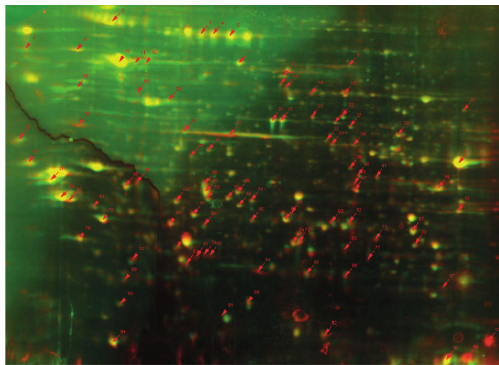
Figure 3: Representative 2D DIGE image of protein analysis. Red signal: overexpressed protein in DNMCs. Green signal: overex- pressed protein in melanocytes from normal skin. Yellow signal: equal expression in both melanocyte types sample groups. Arrows indicate spots excised for MALDI-TOF/TOF